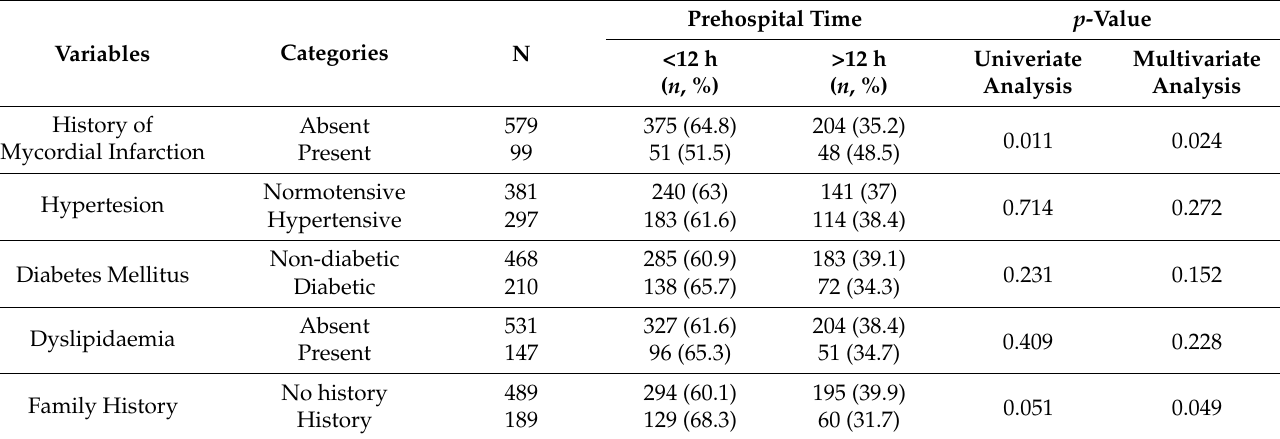
Table 3. Association between chronic diseases and prehospital delay with acute coronary